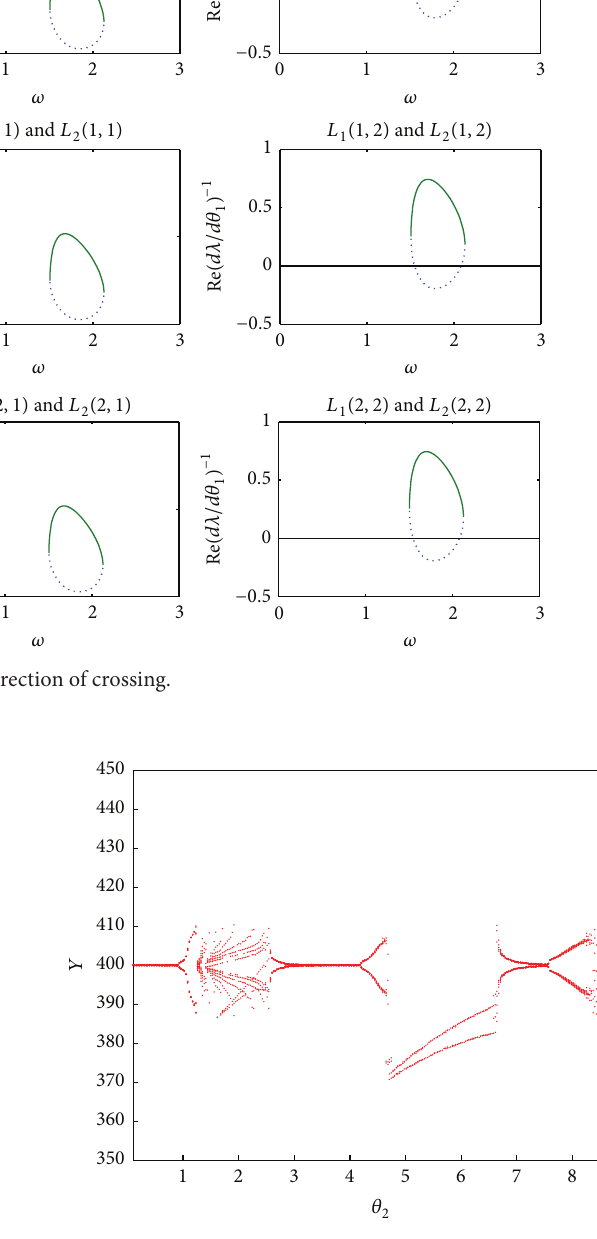
Figure 8: Stability region 𝑆 . Figure 9: Bifurcation diagram ( 𝜃 1 = 0.25 ).